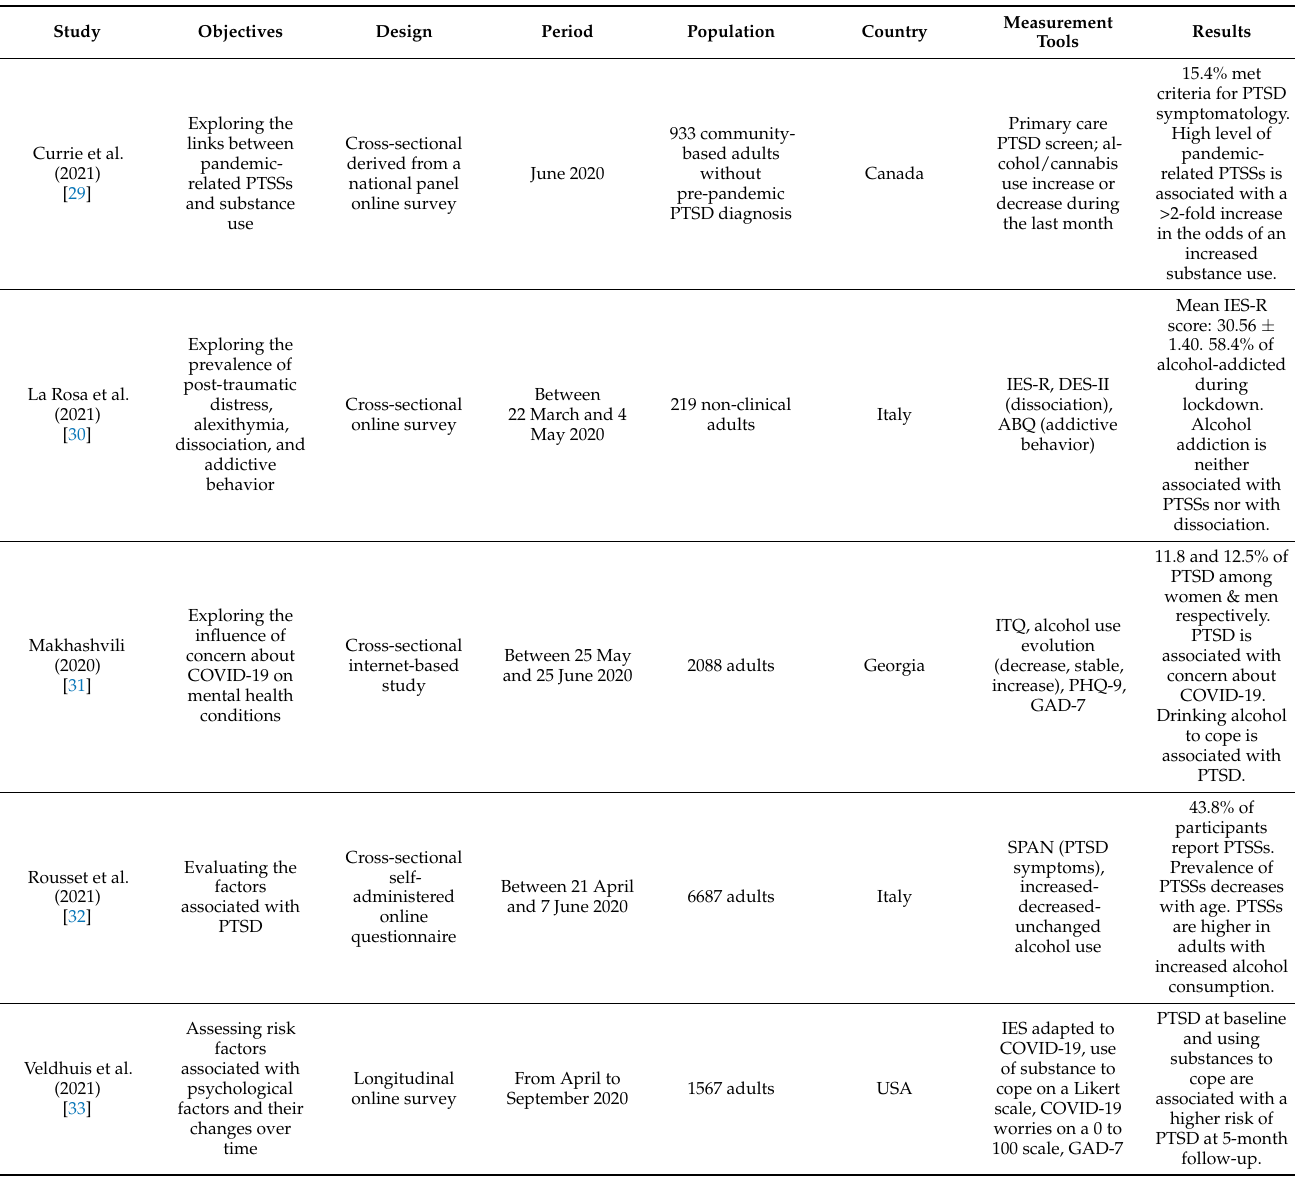
Table 2. Summary of the main data of the studies considered in this review—General